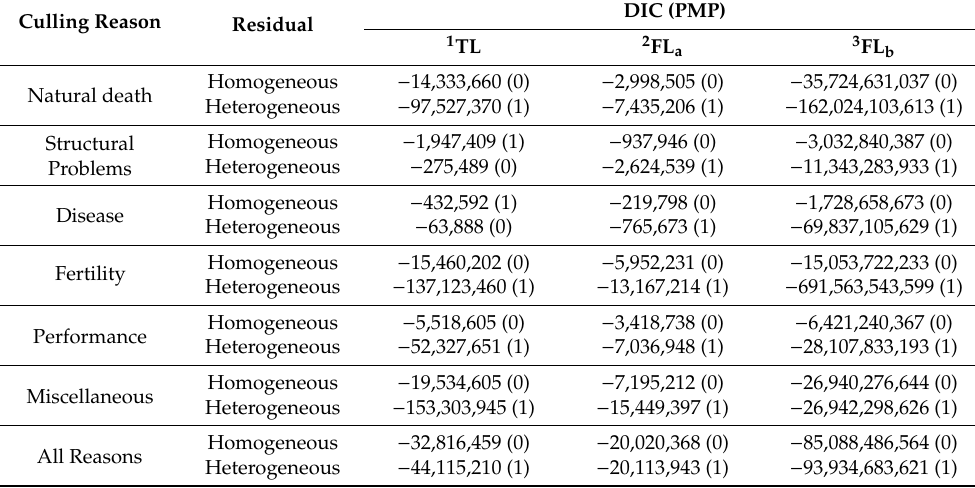
Deviance information criterion (DIC) and the posterior model probabilities (PMP, inside parenthesis) calculated for each group of culling reason and longevity definition, using random regression models based on the fourth order Legendre orthogonal polynomials and assuming homogeneous or heterogeneous residual